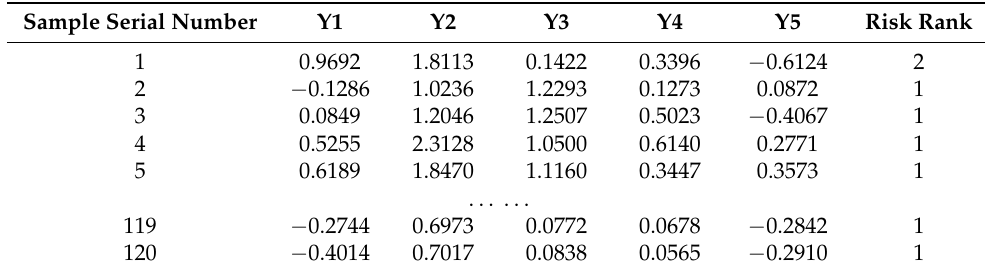
Table 5. Partial data after principal component